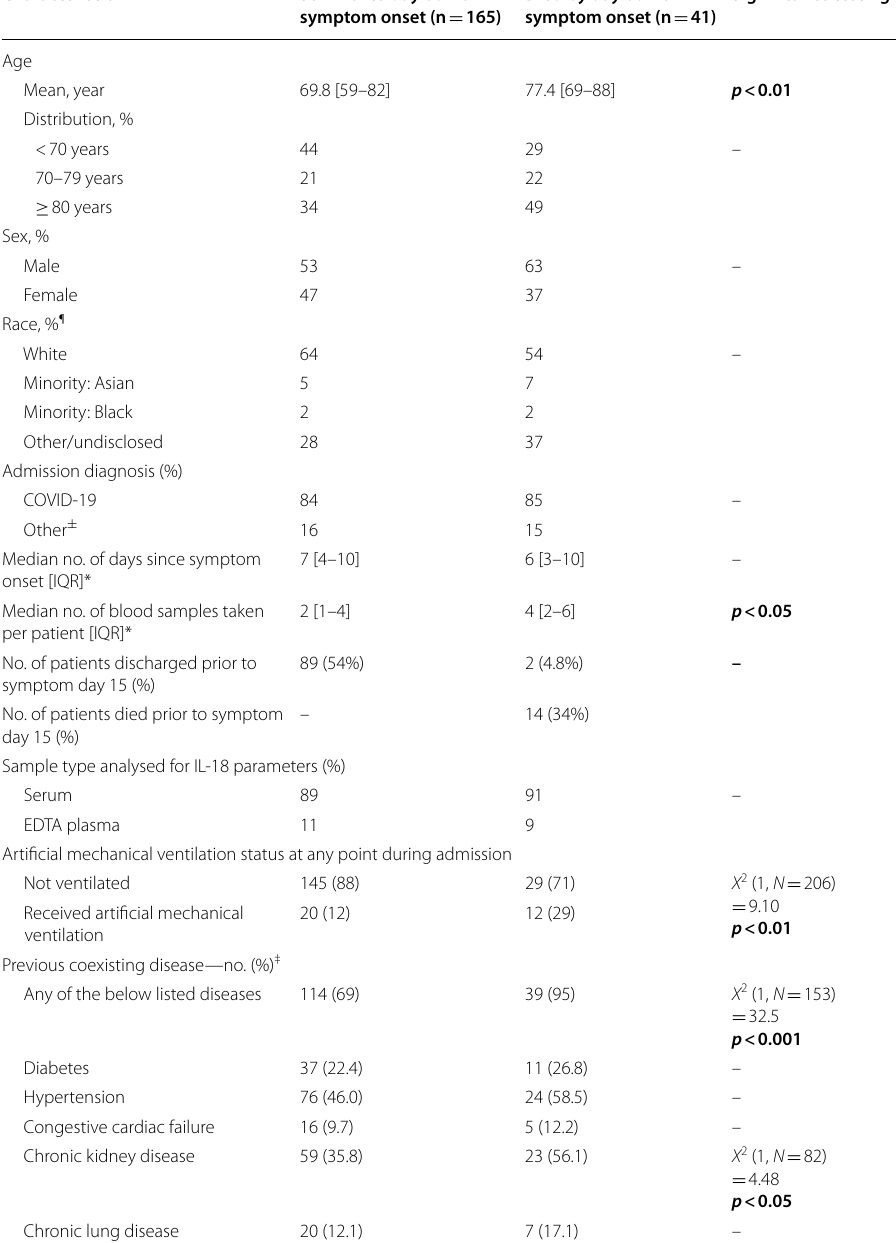
Table 1 Baseline characteristics of 206 patients by 60-day mortality